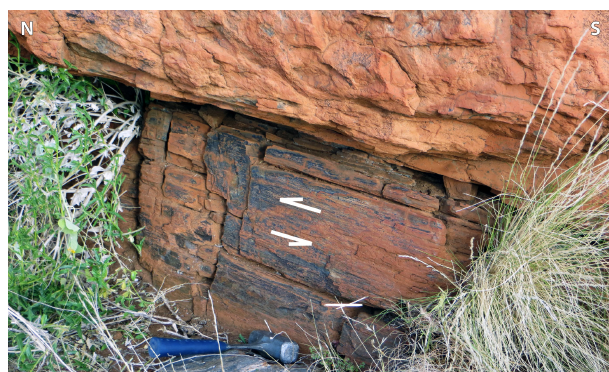
Figure 3. Sharp contact between the ultramylonites of the Woodroffe Thrust (below) and the largely undeformed felsic gran- ulite in the hanging wall (above). Photograph looking perpendicu- lar to the direction of thrusting. Outcrop SW13-135 (coordinates: 131.87939, − 26.21188; location 12 in Fig. 1).